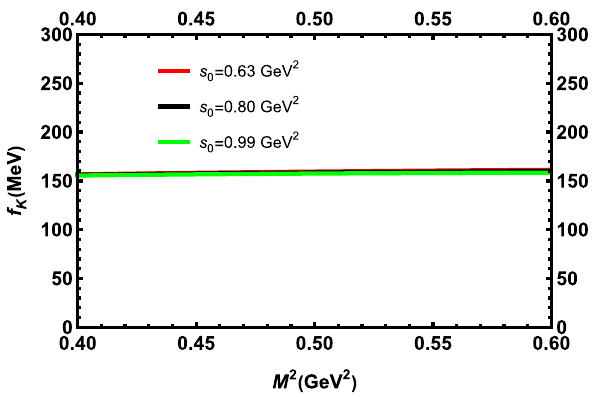
Fig. 1 The decay constant of K + meson in vacuum with respect to Borel mass parameter at different continuum thresholds Table 1 Mass and decay constant of K + meson in vacuum compared with the Experimental data and Lattice QCD results. PS represents the presents study